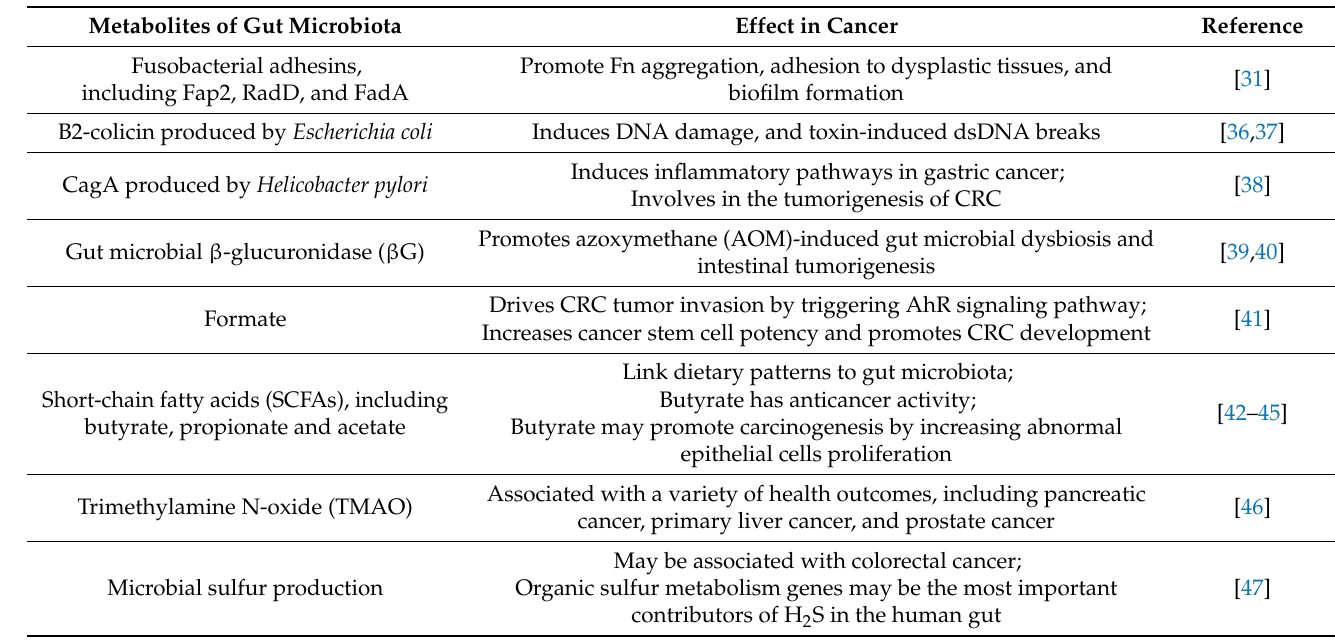
Table 2. Metabolites of gut microbiota and their